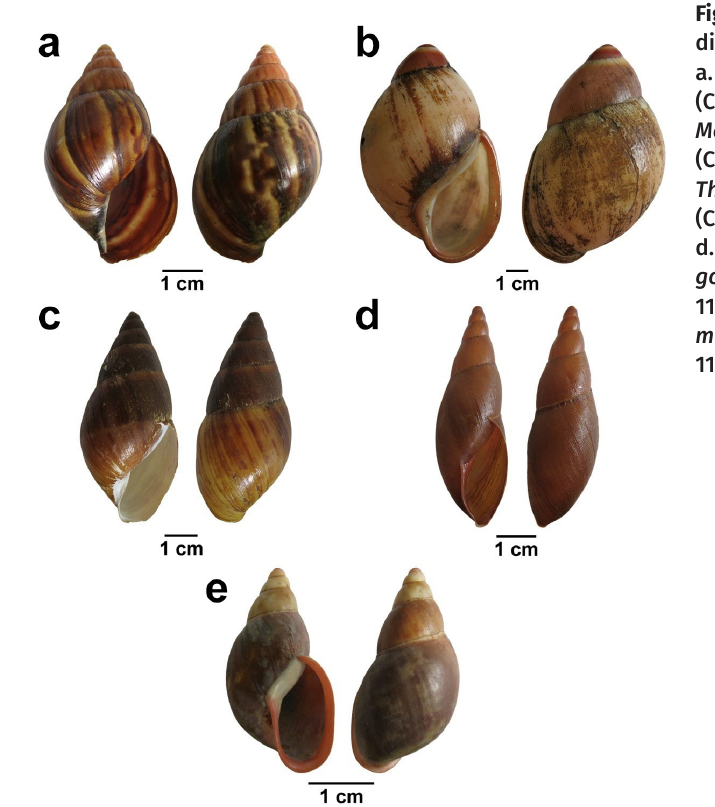
Figure 8. Shell in different